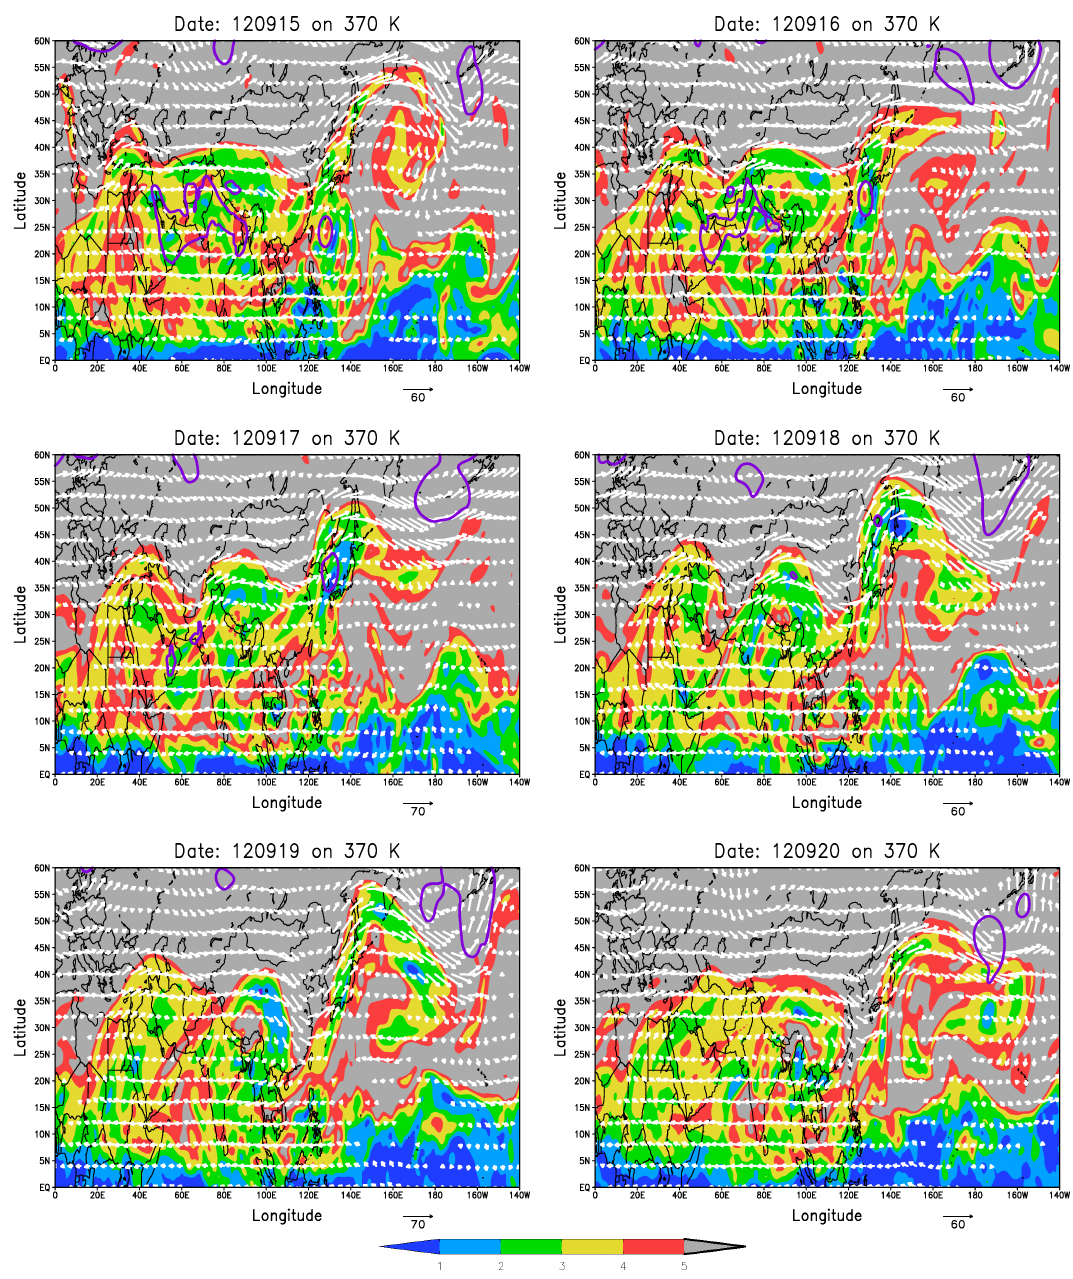
Fig. 7. Continued. Figure 7. Time sequence of PV fields (colour shading in PVU) over Asia at 370K potential temperature from 9 to 20 September 2012 based on ERA-Interim reanalysis data. The horizontal winds are indicated by white arrows. To show the position of tropospheric low-pressure systems in particular the super typhoon Sanba (e.g. ≈ 20 ◦ N 130 ◦ E on 14 September, ≈ 25 ◦ N 130 ◦ E on 15 September, ≈ 30 ◦ N 130 ◦ E on 16 September, and ≈ 40 ◦ N 130 ◦ E on 17 September) the sea level pressure of 1000hPa is marked as a thick purple